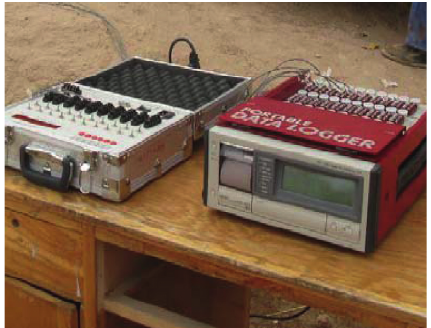
Figure 6: Data acquisition